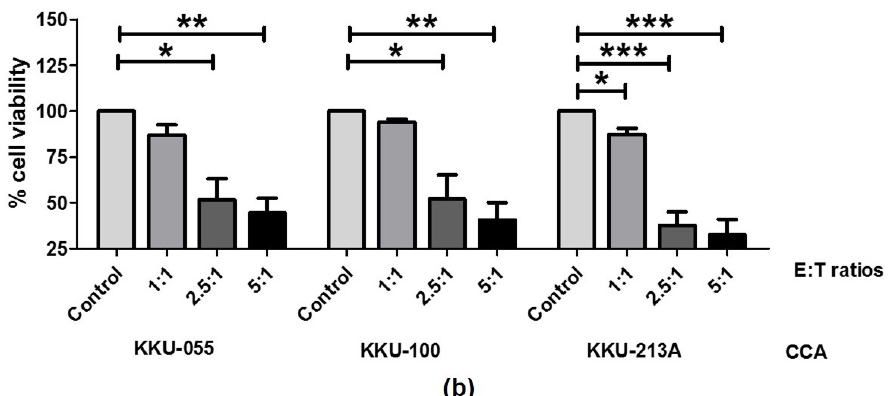
Figure 1. NK cell cytotoxicity in the killing of CCA cells. The NK killing ability was determined in KKU-213A, KKU-100, and KKU-055 by killing assay. The viable cells, after NK cell co-culture at E:T ratios of 1:1, 2.5:1, and 5:1, were observed under the fluorescence microscope ( a ). The fluorescence intensity was measured using the ImageJ program to represent the % cell viability relative to that of a no-treatment control ( b ) (* indicates p < 0.05; ** indicates p < 0.01 and, *** indicates p < 0.001.).